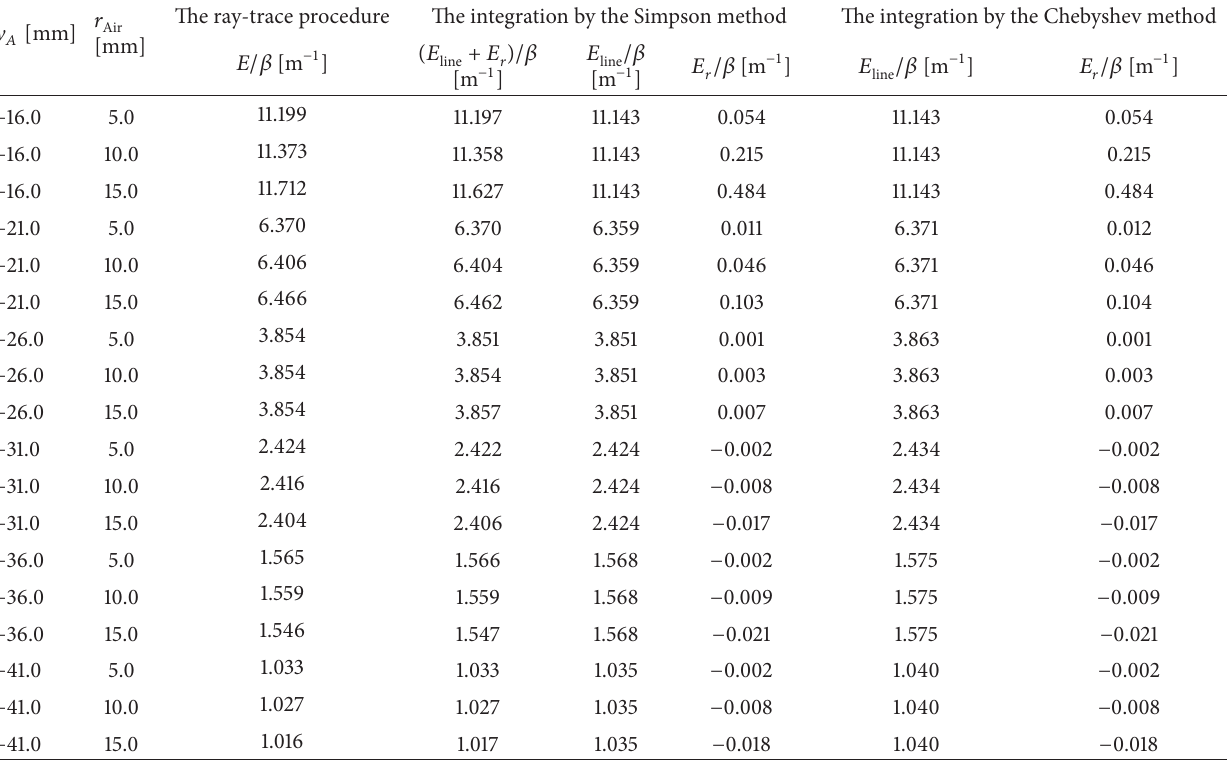
Table 1: The values of fluence rate. The transmittance of 10mm thick water layer is 60%.